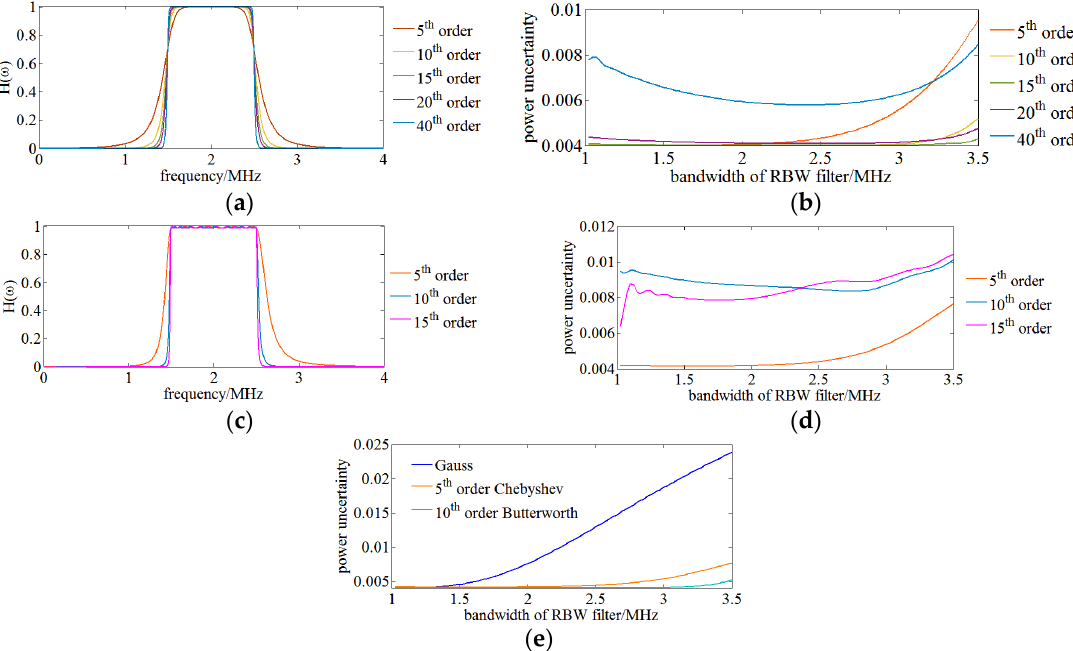
Figure 4. ( a ) The absolute value of the transfer function of Butterworth filters of different orders; ( b ) Power uncertainty of Butterworth filters of different orders as RBW filters; ( c ) The absolute value of the transfer function of Chebyshev filters of different orders; ( d ) Power uncertainty of Chebyshev filters of different orders as RBW filters; ( e ) Comparison of power uncertainty among Gauss, 5th order Chebyshev, 10th order Butterworth RBW filters.